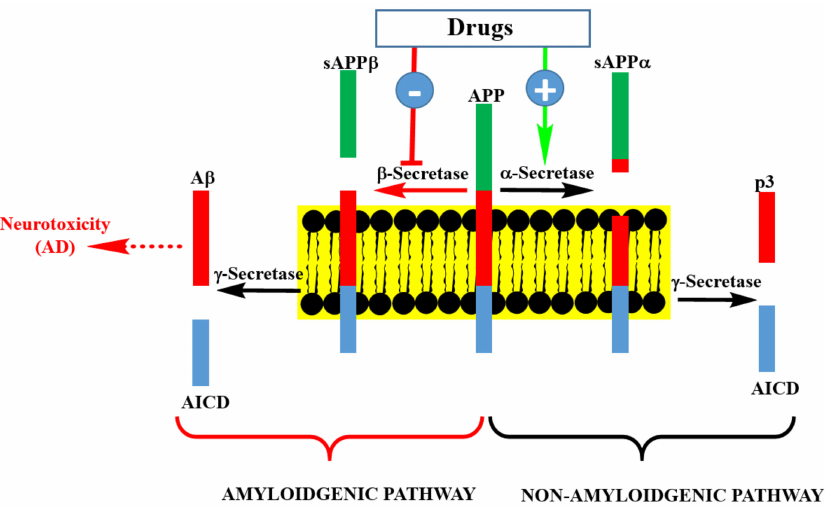
Figure 2. Pathways of A β precursor protein (APP) processing and A β formation. Inhibition of β -secretase by pharmacological agents is at the center of drug discovery research for AD therapy. This could be achieved by small molecular weight compounds or an antibodies approach. Enhancing the activity of γ -secretase by pharmacological agents is another possibility, though it is a less popular strategy than β -secretase inhibition. Targeting soluble or aggregated A β by various agents is another approach being undertaken in AD drug